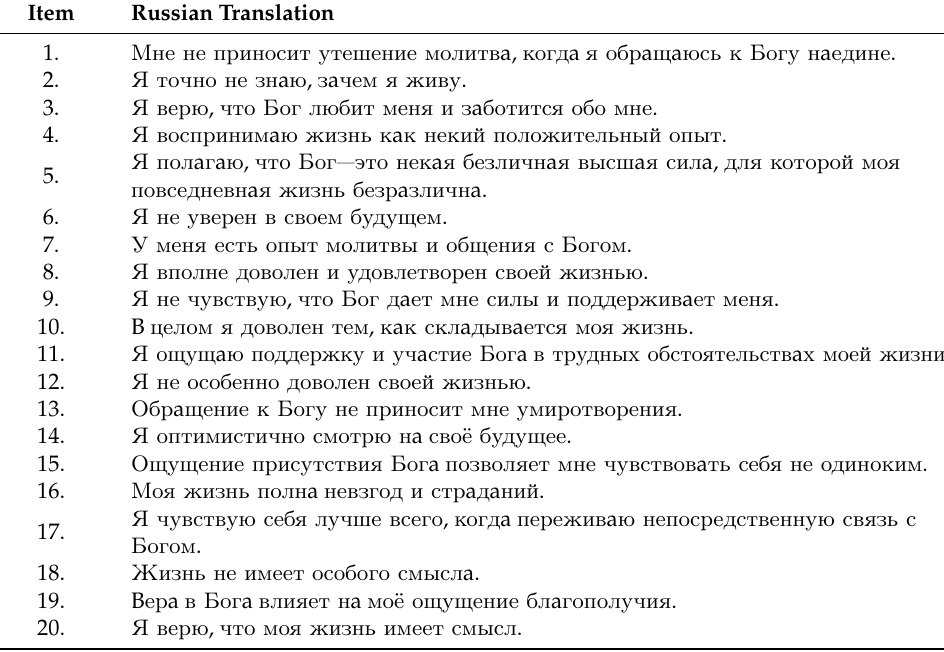
Table A1. Russian version of the Spiritual Well-Being